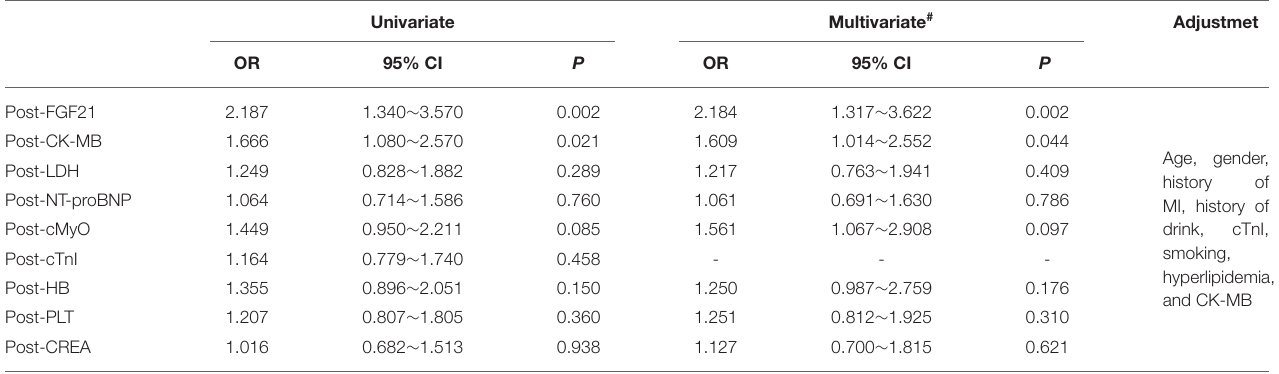
TABLE 3 | Logistic regression analysis of MACE in 265 patients with MI who had undergone CABG. Univariate